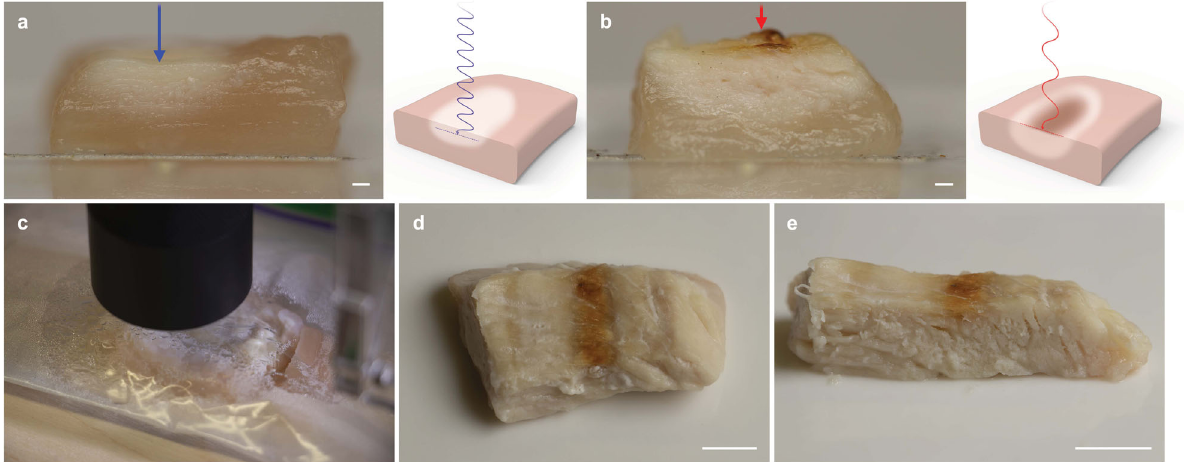
Fig. 7 Multiwavelength laser cooking. a Cross-sectional cut of laser-exposed chicken from a 5W blue laser (blue arrow) with graphic showing transmission of blue laser light. b Cross-sectional cut of laser-exposed chicken from an 8 W CO 2 infrared laser (red arrow) with graphic showing absorption of IR light at sample surface. Due to the discrepancy in laser power, the 5 W blue laser performed two passes of the same trochoidal path (total exposure time = 100s) and the 8W IR laser was exposed to the sample for one pass with a cycle time of 63s to ensure total energy was constant (500J). c Thinly cut piece of chicken being laser-cooked by a 9 W near-infrared laser (black cylinder) within a sealed package. d Top view of fi nal-cooked piece of chicken with laser-induced “ grill ” mark. e Cross-section cut of same sample. Scale bars, ( a , b ) 1mm and ( d , e )